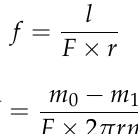
Figure 3. Schematic diagram of wear testing equipment. 3. Results and Discussion 3.1. Effect of Copper Morphology on the Performance of the Sliding Plate For studying the influence of copper morphology on the impact performance, the impact strength of sliding plate materials prepared by different copper morphologies was measured, as shown in Figure 4a. The sliding plate sample without copper was used as a contrast. It can be seen from the figures that the different forms of copper had significantly different effects on impact properties. The addition of copper powder did not change the impact strength much, increasing it by only 1.28%. The addition of copper fiber and cop ‐ per mesh could improve the impact strength to varying degrees, and the effect of copper fiber was more significant, relatively increasing by 38.53%. The reason for this result is that copper is a ductile material and the addition of copper fibers absorbed the impact energy and delayed or stopped the expansion of cracks at fracture, causing a significant increase in the impact strength of the material. Although the addition of copper mesh